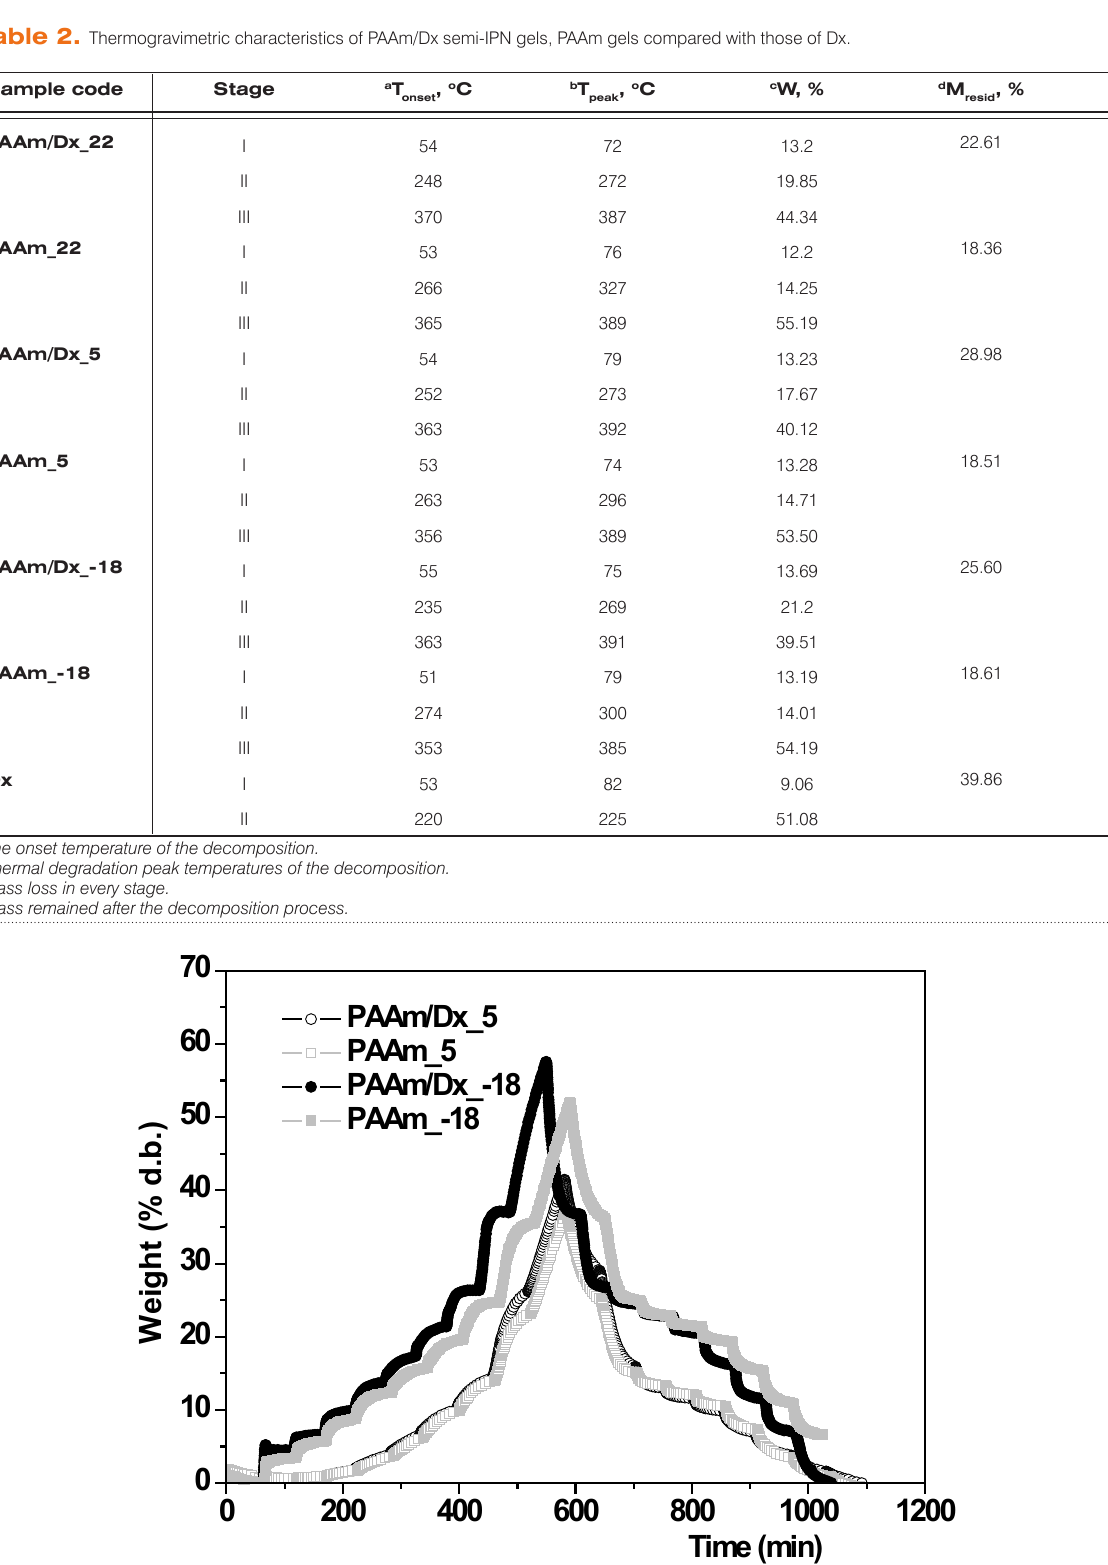
Table 2. Thermogravimetric characteristics of PAAm/Dx semi-IPN gels, PAAm gels compared with those of Dx.